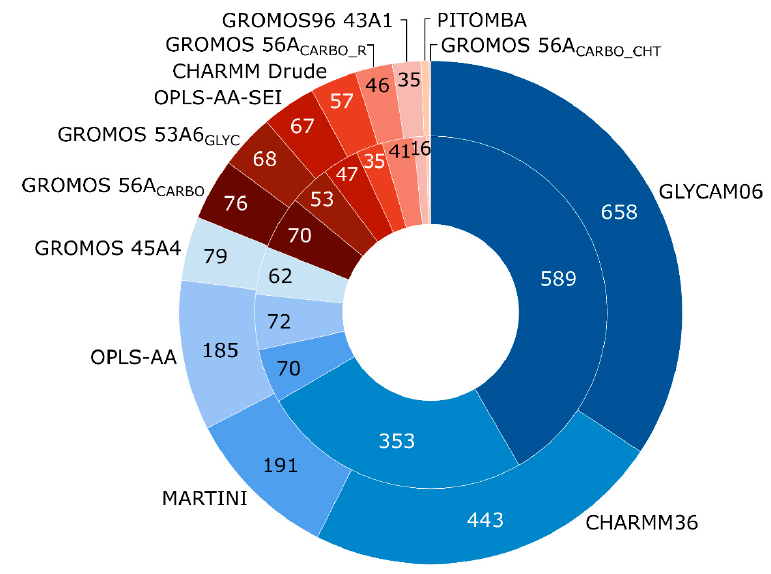
Figure 4. Citations of dedicated force fields in carbohydrate studies for the recent five years, according to Scopus. Outer circle shows total citations (number of citing publications) of force fields in 2015–2020. Inner circle shows citations in articles filtered by a carbohydrate topic. See detailed data, references to original publications, absolute values, and carbohydrate filer details in Supplementary Table S2.